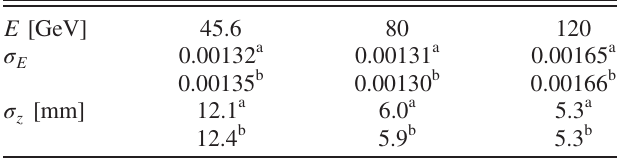
TABLE II. The bunch energy spread and length due to the SR þ BS effect at